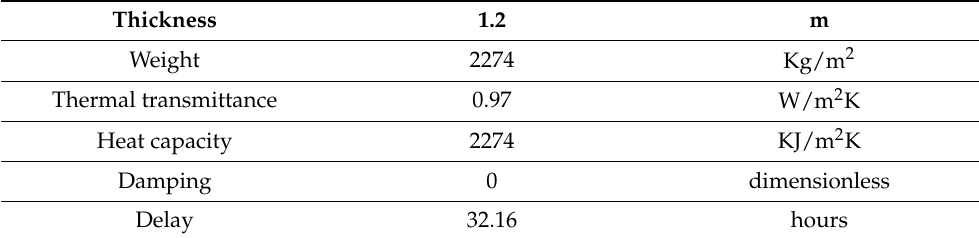
Table 4. Characteristics of the enclosures of the Girona Cathedral [28,29].